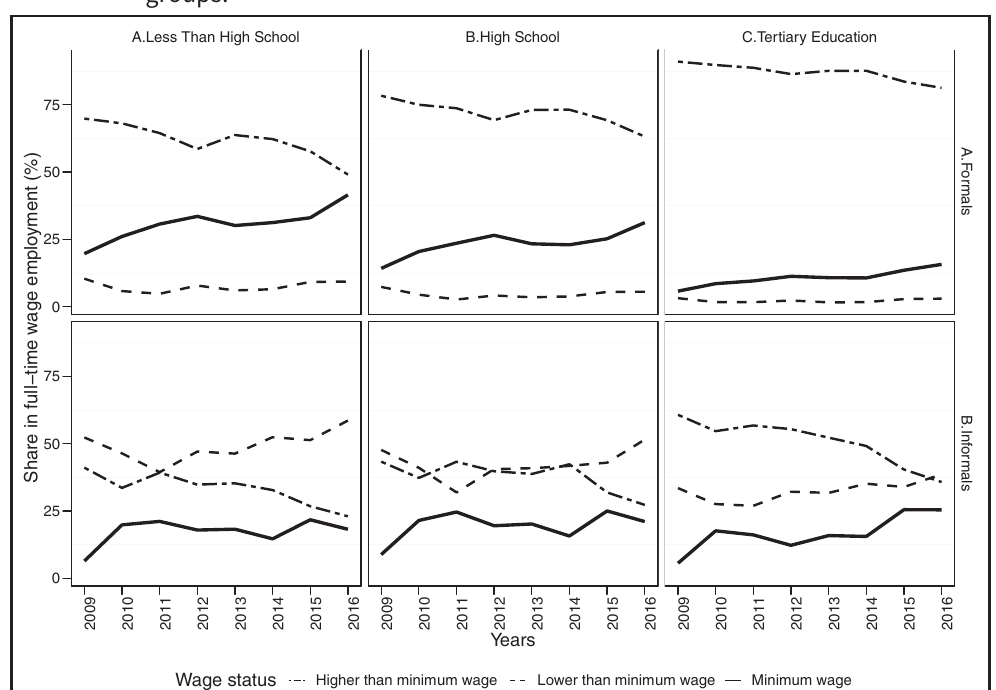
Figure A1 Share of minimum wage workers in formal and informal sectors by education